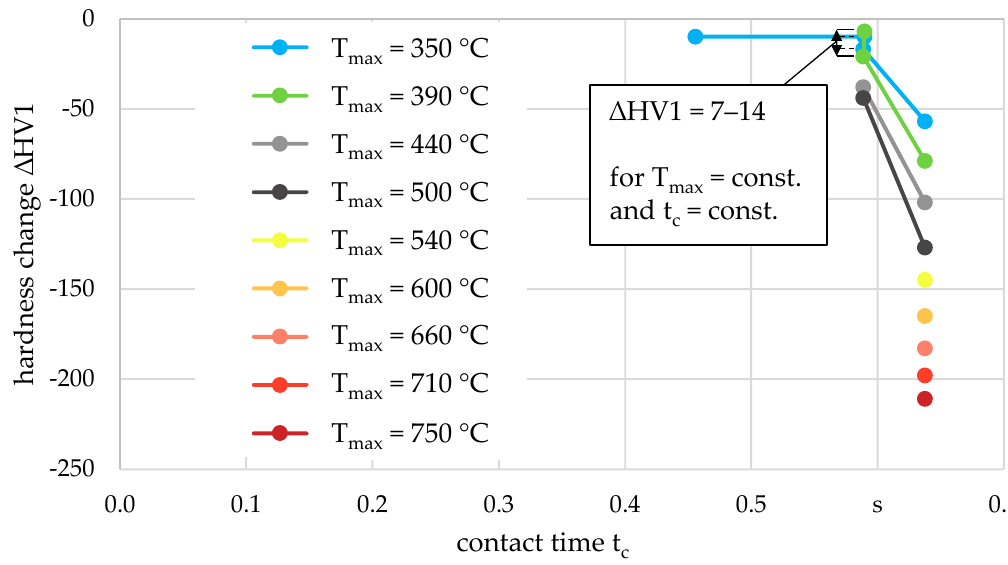
Figure 10. Hardness change dependent on the contact time for given maximum temperatures.